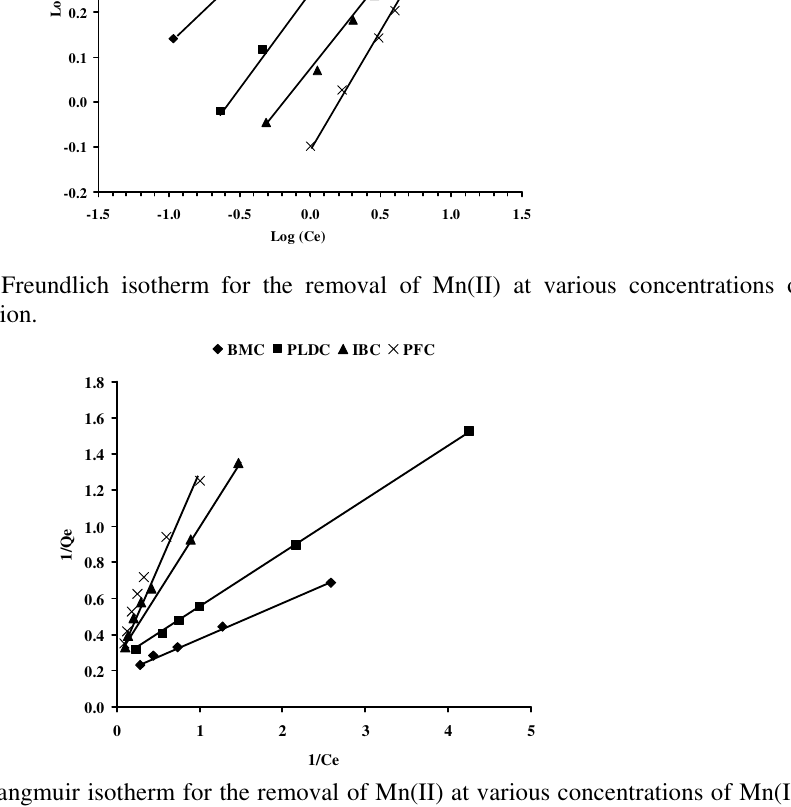
Figure 2. Langmuir isotherm for the removal of Mn(II) at various concentrations of Mn(II)